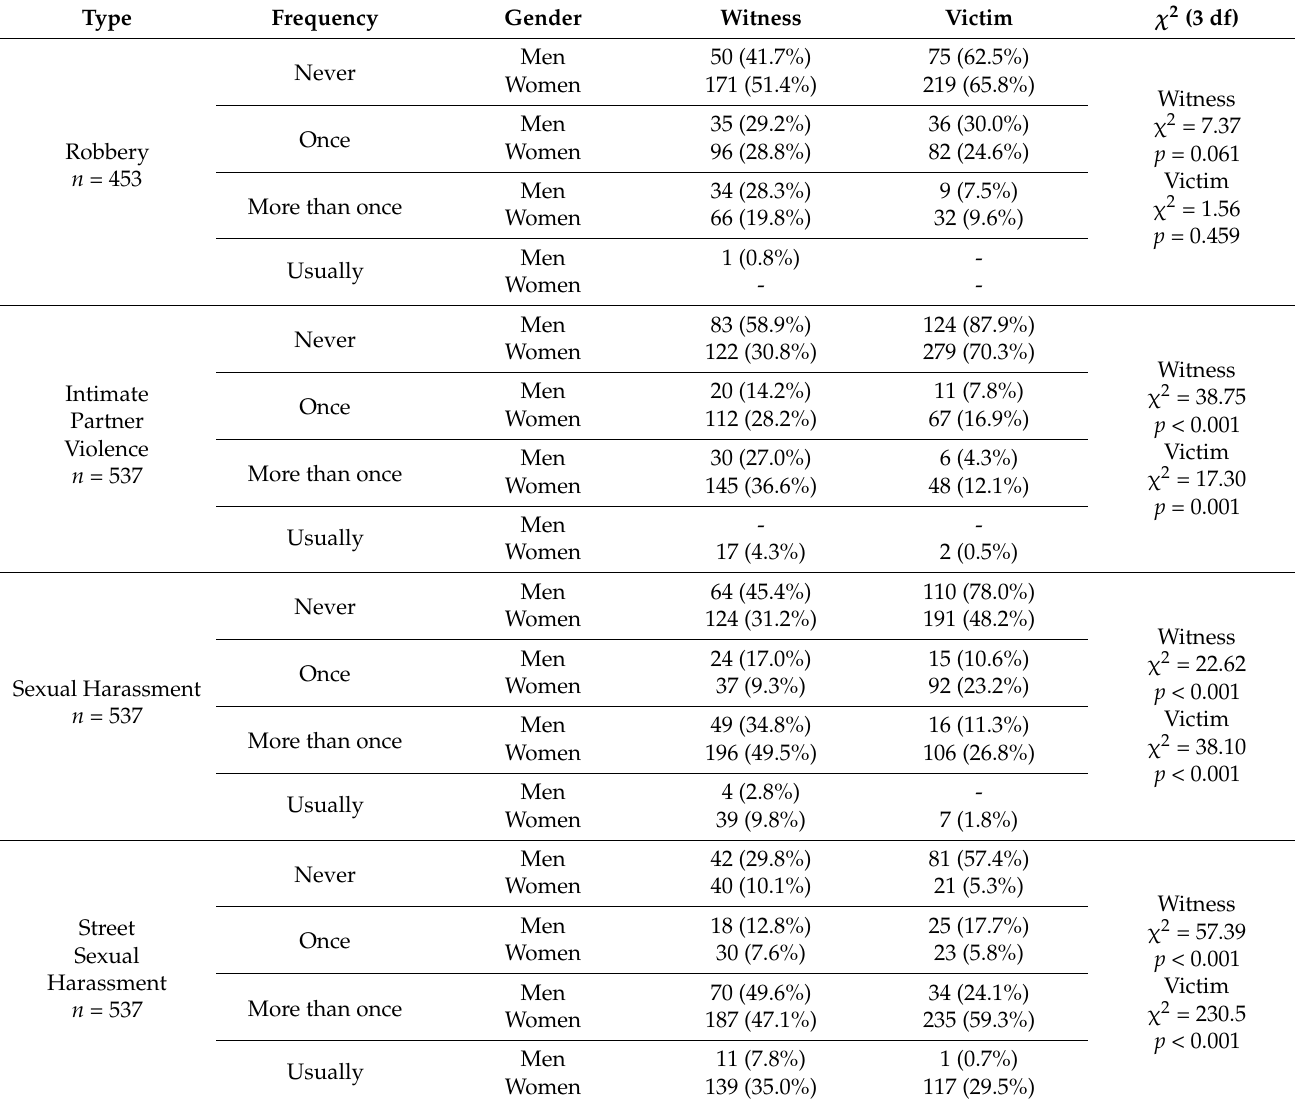
Table 4. Frequency of victimization by